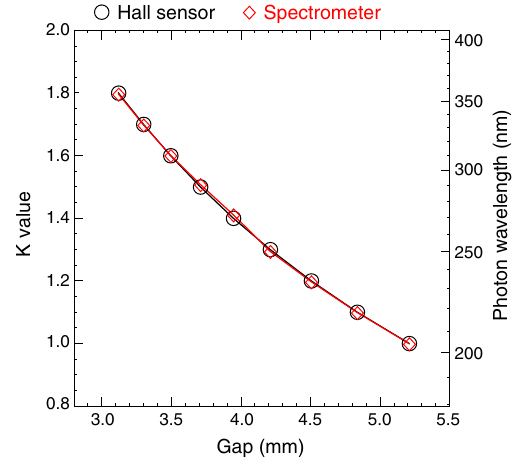
FIG. 70. Undulator K value as a function of undulator gap as derived from magnetic measurements using Hall sensors (black circles) and from spectral measurements of the generated SASE FEL radiation (red